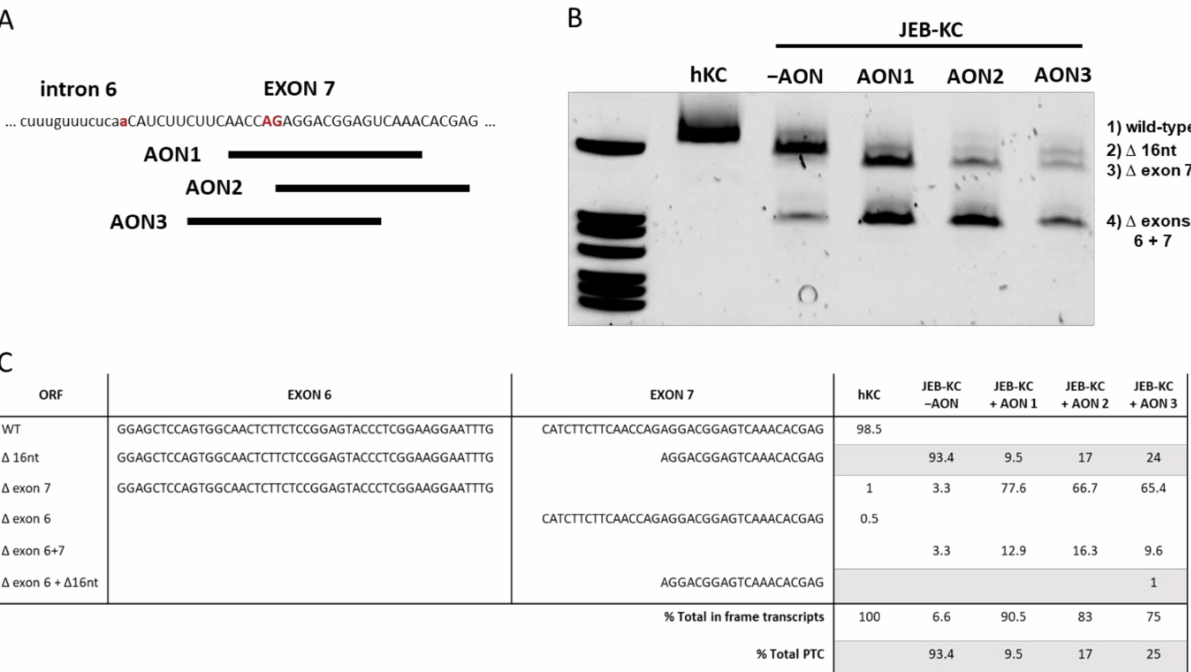
Figure 1. Antisense oligonucleotides (AON)-induced exon skipping. ( A ) Three AONs were designed to bind complementary to the cryptic exon 7 splice acceptor site (red upper case letters). The mutation at the wild-type splice junction isindicated as red lower case letter. ( B ) Exon skipping patterns observed in AON-treated vs. untreated ( − AON) junctional epidermolysis bullosa patient-derived keratinocyte line (JEB-KC) compared to healthy control KC (hKC). Untreated JEB-KC show a distinct band that corresponds to the deletion of 16 nts of exon 7 ( ∆ 16 nt). All AON-treated samples show splicing products corresponding to the skipping of exon 7 ( ∆ 7) or exon 6 and exon 7 in combination ( ∆ 6+7). The latter was also found in untreated JEB-KC. All bands were analyzed by Sanger sequencing. ( C ) Next-generation sequencing (NGS) results of COL17A1 mRNA splice variants. All numbers are given as percentages, and grey lines indicate that transcripts have an open reading frame (ORF) divergent from the wild